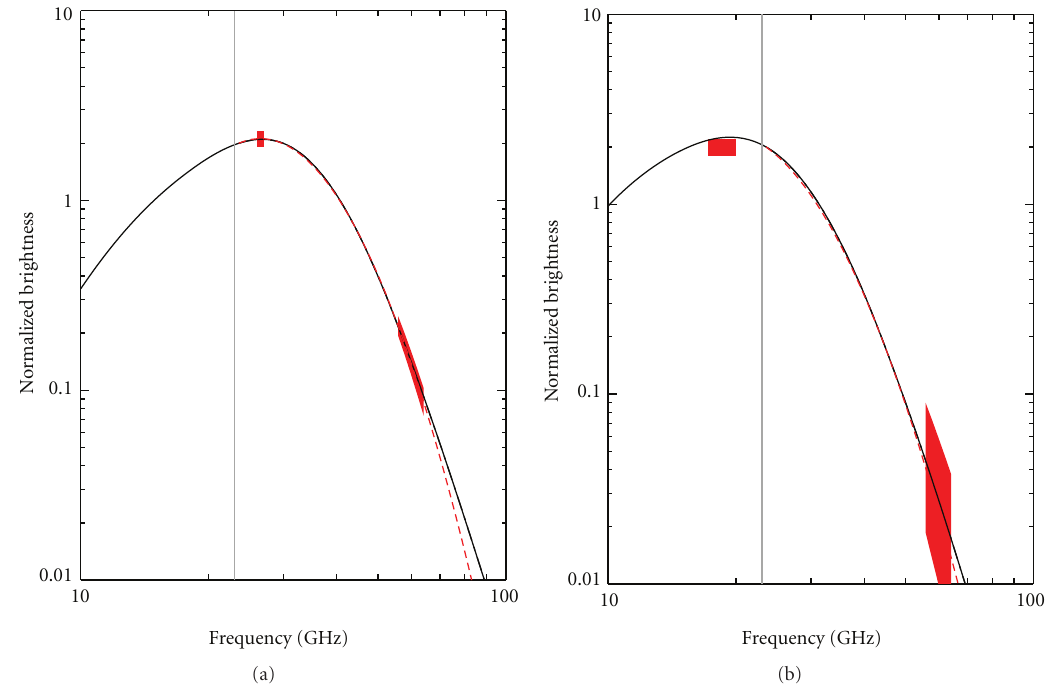
Figure 3: Comparison of true input AME spectra (black solid lines) with CCA estimates (red dashed lines) for two AME models, one peaking at 26GHz (a) and one at 19GHz (b). The red shaded areas show the recovered ν p and m 60 with 1 σ error bar. The results for the peak frequency are ν p = 26 . 5 ± 0 . 5 and ν p = 18 . 5 ± 1 . 5 for (a) and (b), respectively. The grey vertical lines indicate the frequency of 23GHz which sets the limit of our data.